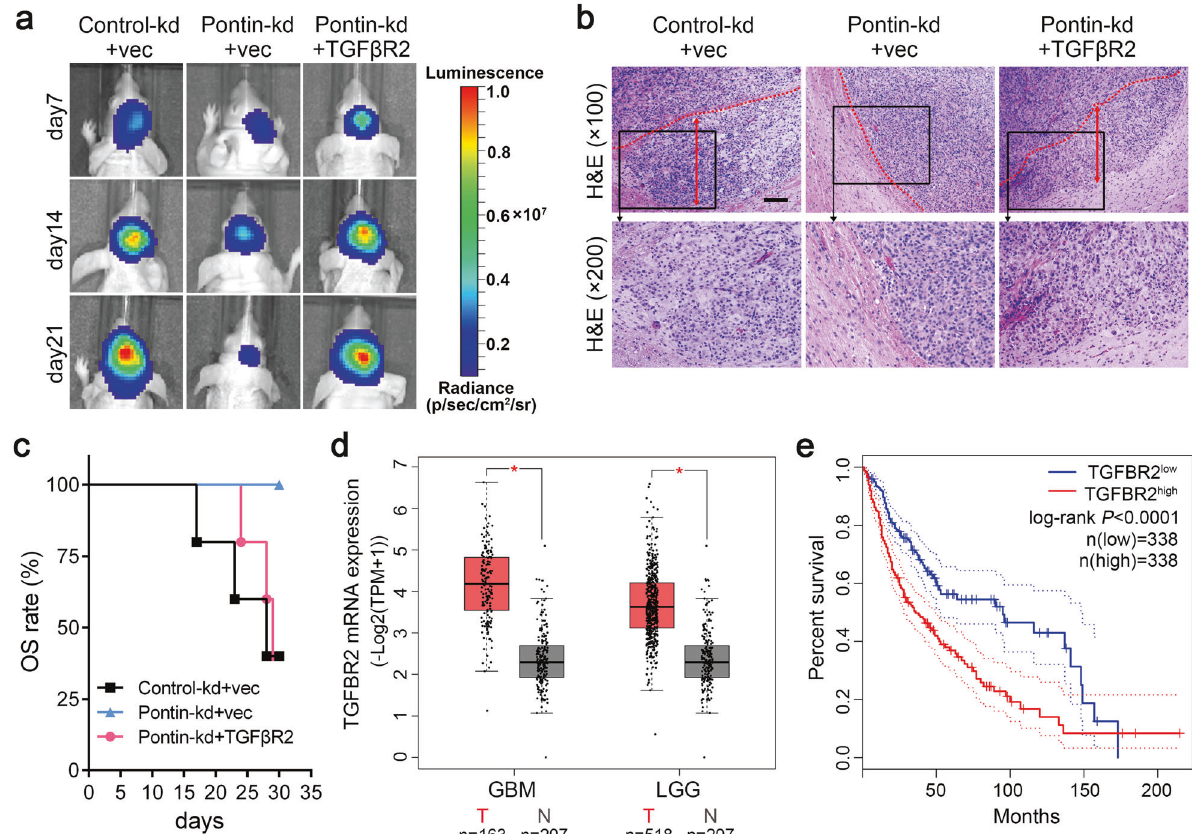
Fig. 8 TGF β R2 restoration recovers xenograft growth and its higher levels indicate the worse outcomes in glioma patients. a Representative bioluminescent images reveal the xenografts in mice brain formed by indicated U87MG cells. b Representative H&E staining images of the indicated xenografts. Red dotted lines outline the junctions between xenografts and surrounding non-tumoral brain tissues. Invasion distances was indicated by red double-sided arrows. Scale bar, 50 μ m (×100). c Survival curve of the glioma-bearing nude mice. d Box plots comparing TGFBR2 mRNA expression between normal brains (N) and tumours (T) in GBM and LGG (lower-grade glioma) using the data from GEPIA dataset. e Kaplan – Meier analyses the OS of all the glioma patients (GBM and LGG) from the GEPIA dataset. Patients were divided into high and low expression groups according to TGFBR2 expression medians of the corresponding cohorts. P -values calculated by the log-rank (Mantel – Cox) test are shown.